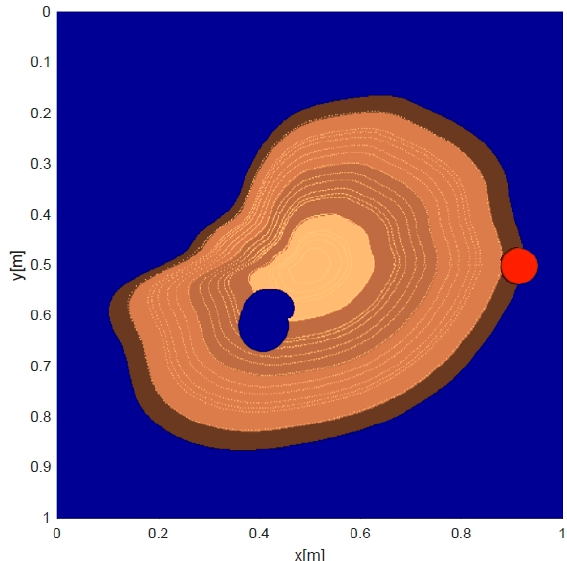
Figure 4. The complex-shaped hardwood trunk scenario investigated using FDTD numerical modelling. The starting point of the measurements, taken clockwise, is represented by the red circle.